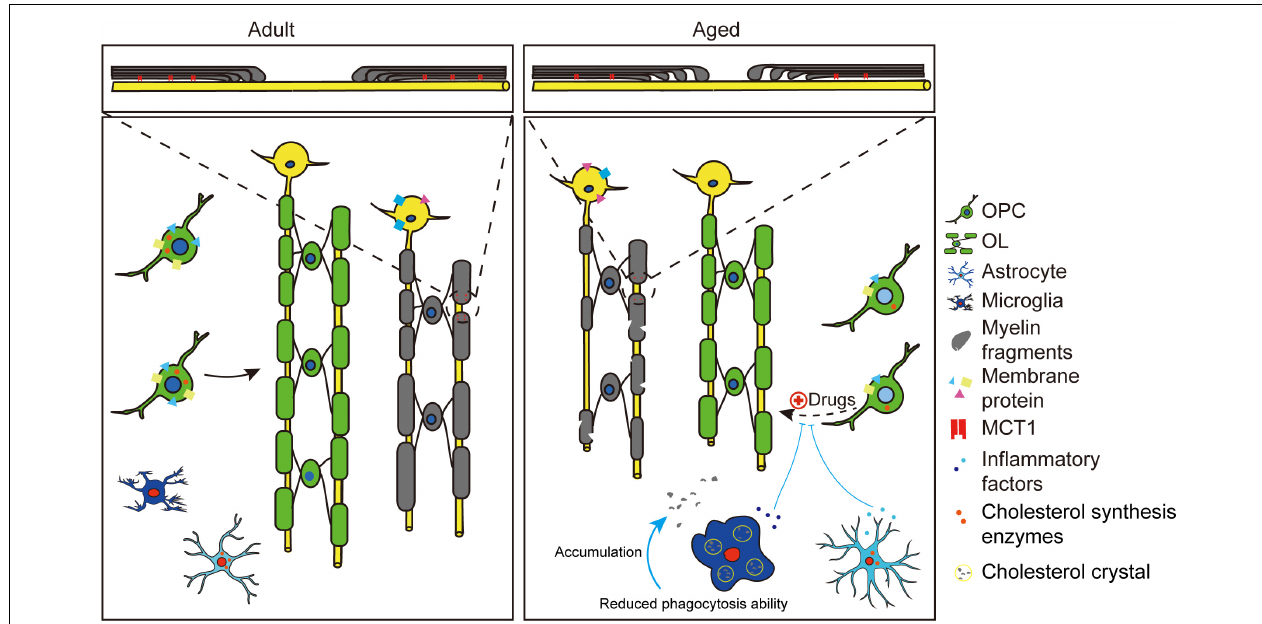
FIGURE 1 | Schematic showing changes of OPCs and OLs during aging. Compared to adults, aged brains showed myelin degeneration and inhibited myelinogenesis. The pre-existing myelin (gray) showed quantitative and qualitative changes during aging. Quantitative alterations include decreased OLs number and internodes, thinner myelin sheaths and shortened internodes. Qualitative changes include myelin debris formation, microstructural changes like paranodal pilling (zoomed area) and altered membrane protein expression (decreased MCT1, decreased GLAST1, and increased NMDA). Inhibited myelinogenesis (green) may be due to the age-related intracellular and extracellular changes of OPCs. Intracellular changes include varied epigenetic regulation (light blue nucleus), decreased cholesterol synthesis enzymes and decreased receptor expression (GPR17, APJ). Extracellular changes include stiffness of extracellular matrix (ECM) and age-related activation of astrocytes and microglia cells. Proinflammatory factors (cytokines, chemokines) released by activated glial cells will inhibit differentiation of adult OPCs. Activated microglia cells are associated with cholesterol crystal formation (see yellow circles) and reduced phagocytic ability, resulting in myelin debris accumulation. Activated astrocytes show decreased cholesterol synthesis enzymes. Note that the inhibited differentiation of OPCs in aged brain could be rejuvenated by drugs like clemastine.